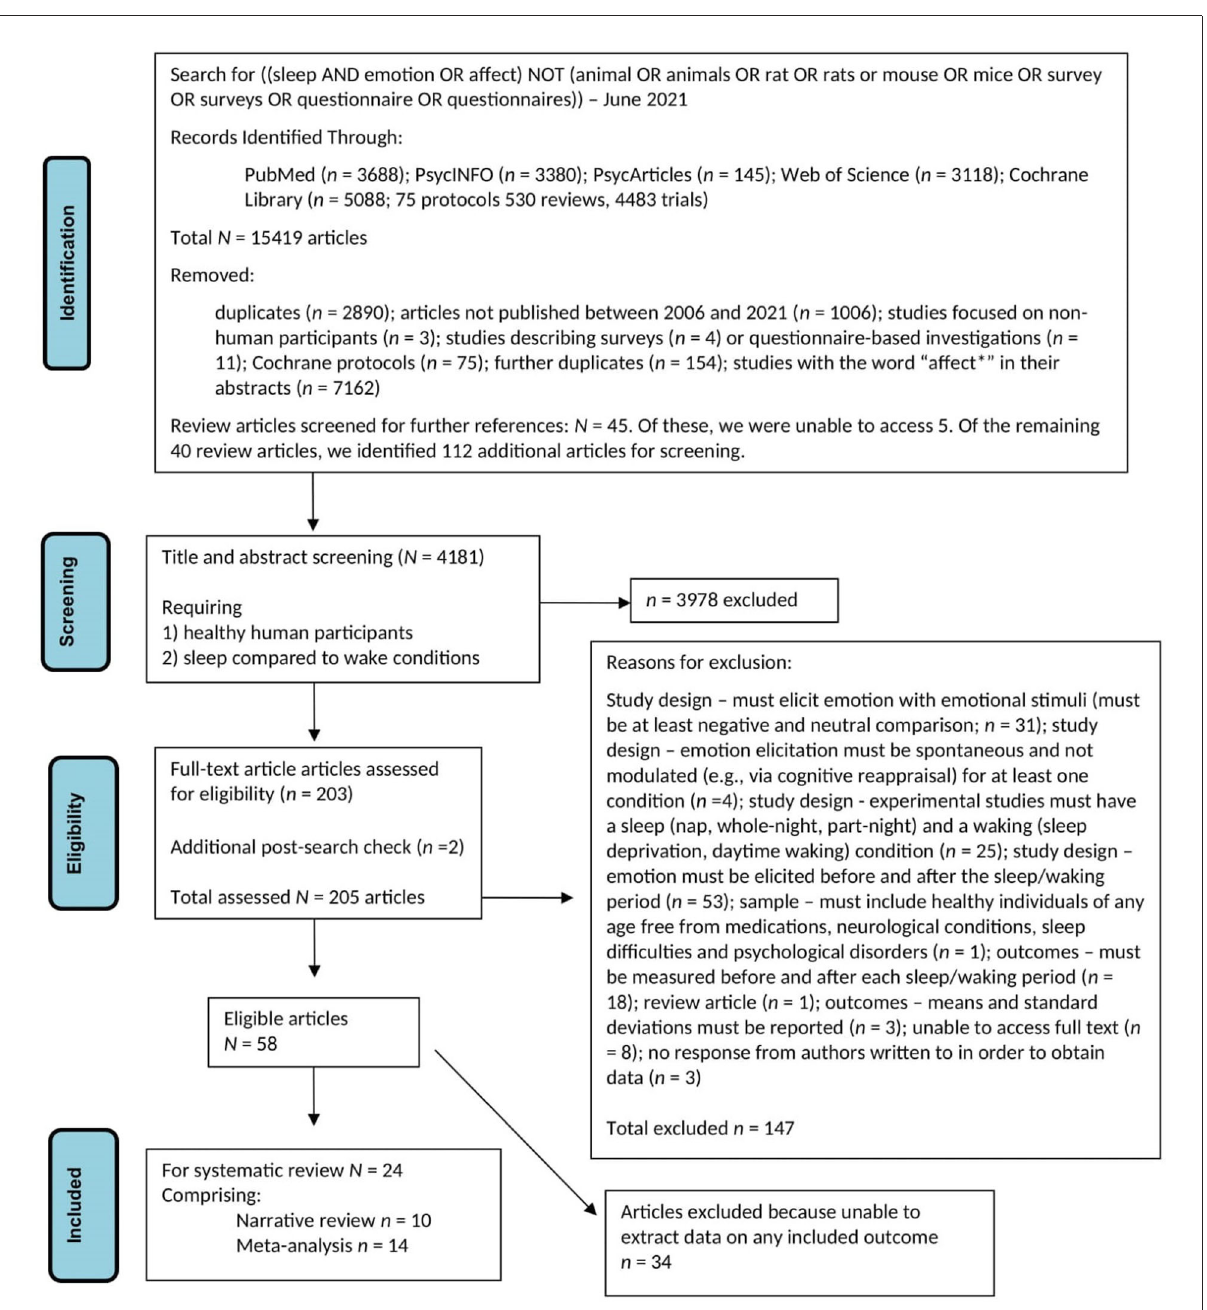
FIGURE1 Flow diagram for literature search and subsequent screening and evaluation of retrieved